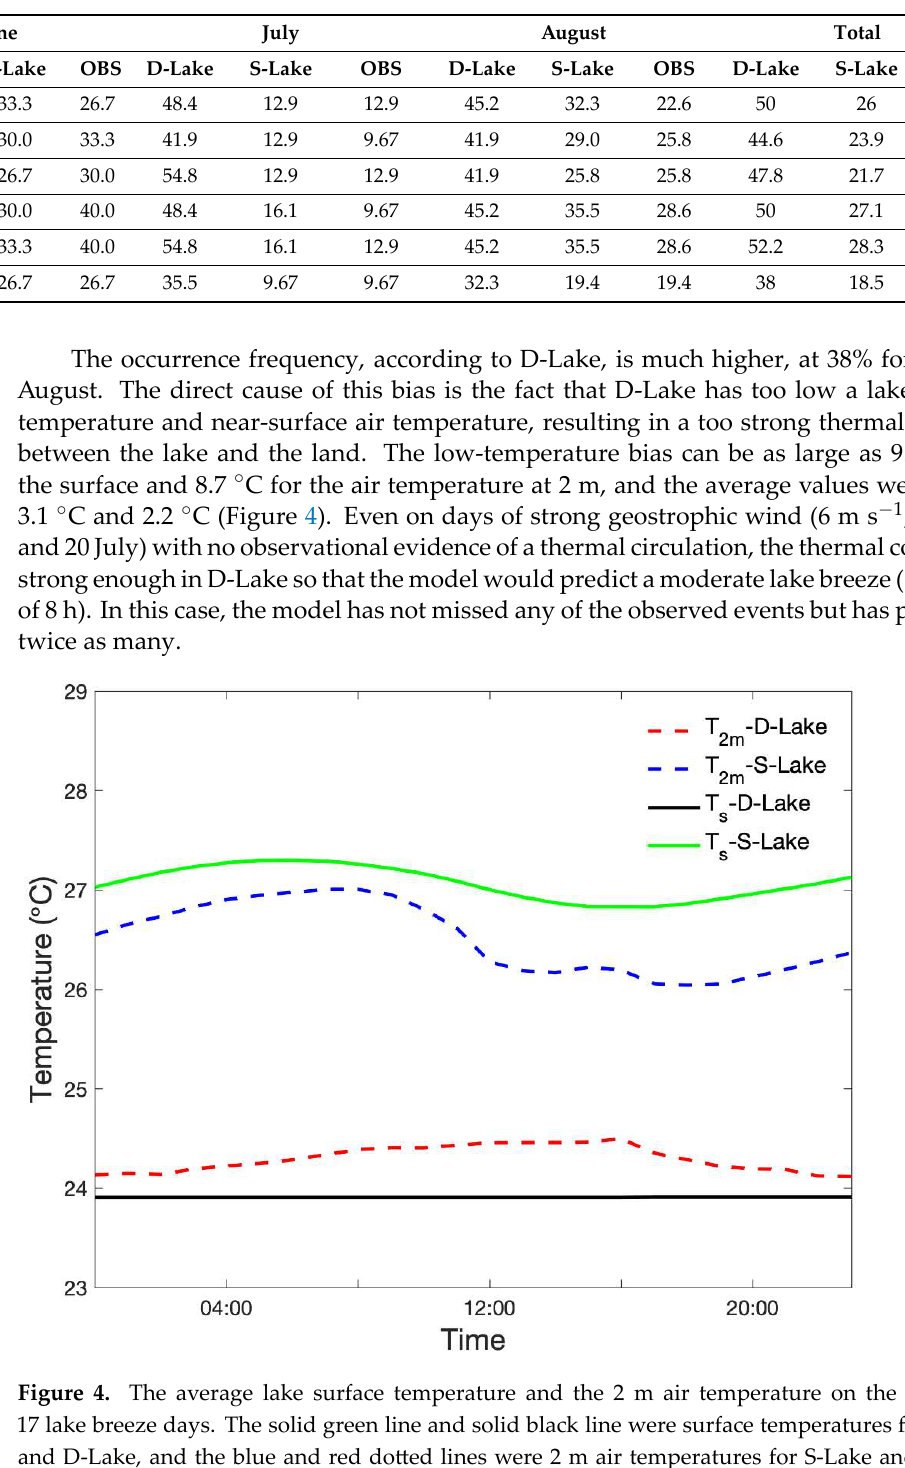
Table 4. The percentage (%) of days per month with lake breeze.